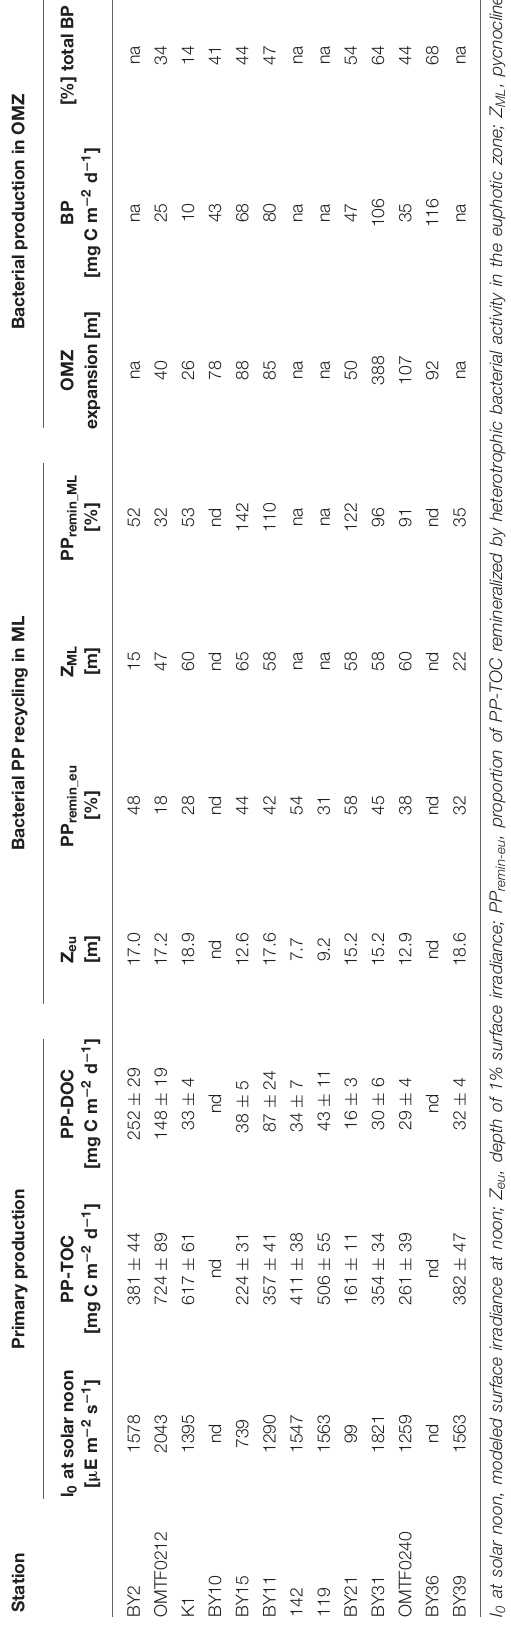
FIGURE 5 | Heterotrophic bacterial production in different types of bottom water (BW) and in sulfidic waters.